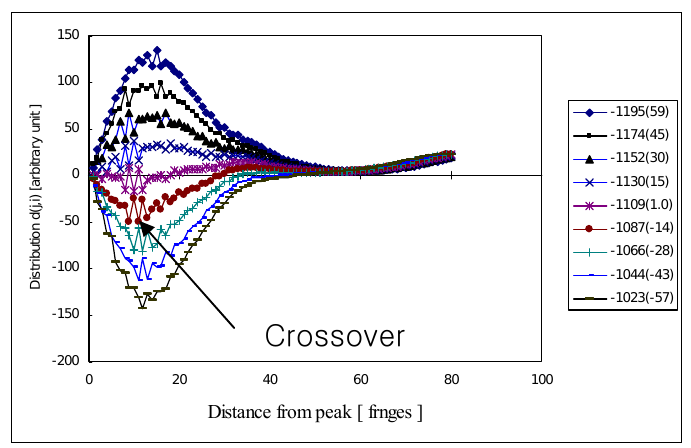
Figure 6 . Distribution d ( j,i ) of fringe scan H373.